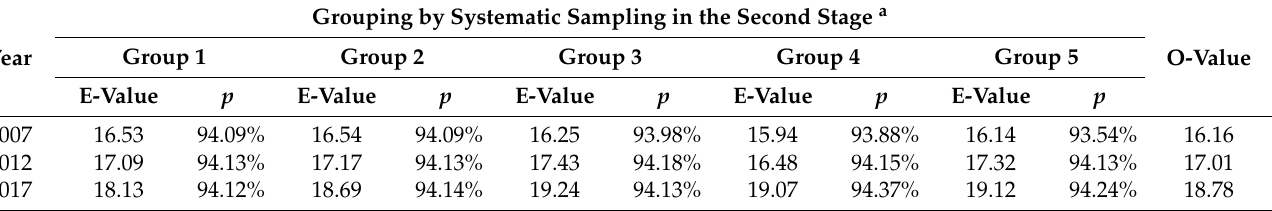
Table 2. Estimation results of the forest volume by systematic sampling in the second